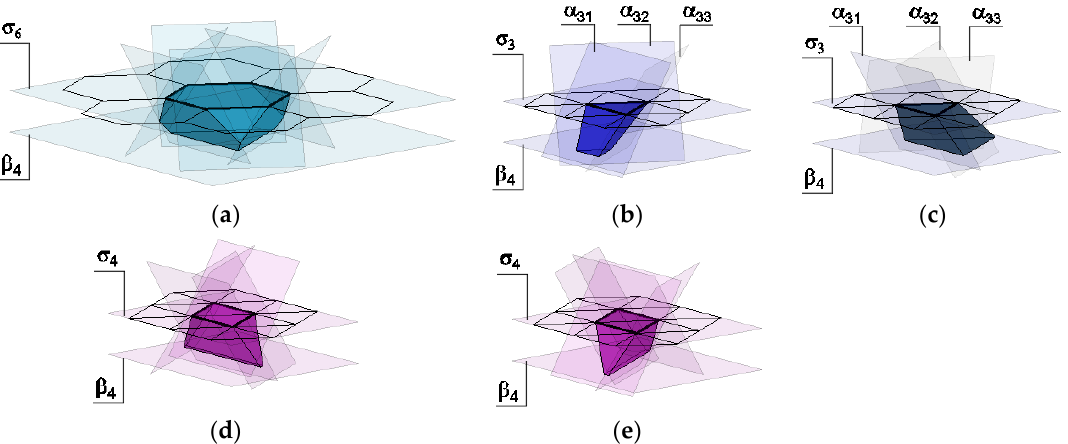
Figure 11. Modeling of one-sided smooth components based on: ( a ) a regular hexagon; ( b , c ) an equilateral triangle; and ( d , e ) a rhombus.